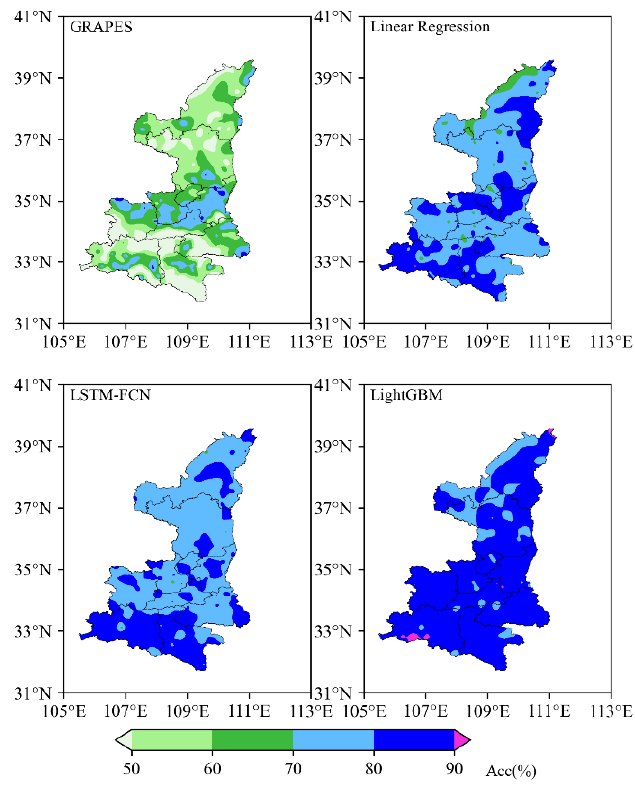
Figure 6. Spatial distribution of forecast accuracy from the model and three correction methods.